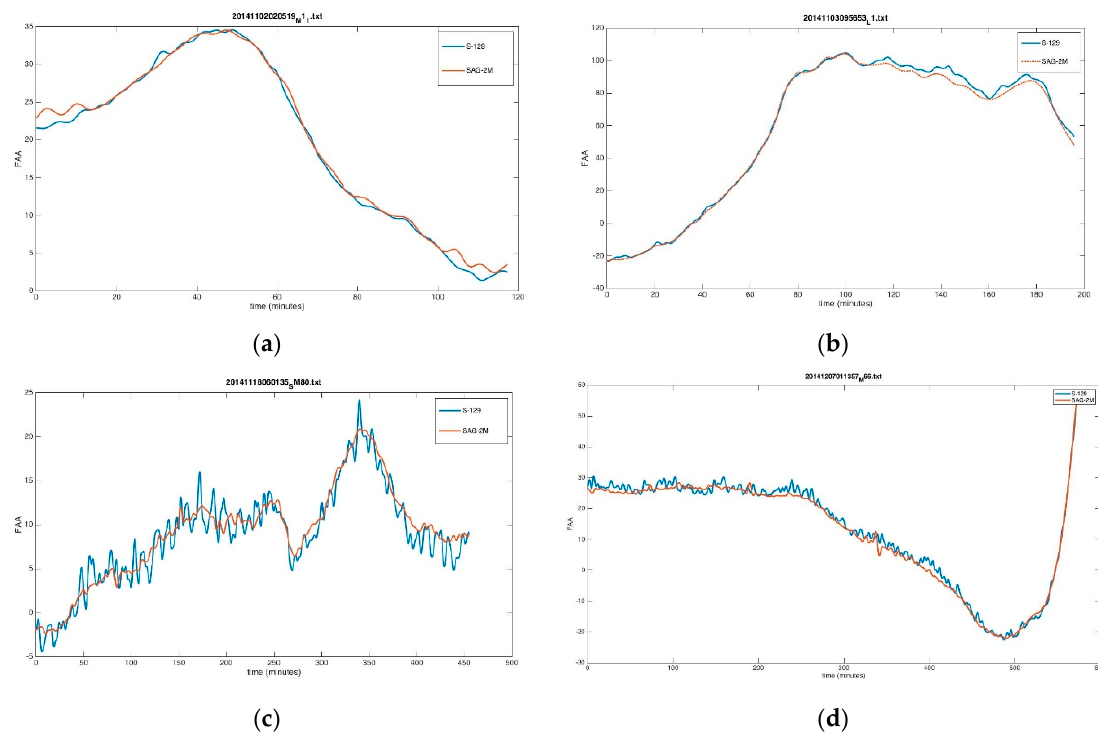
Figure 6. Profile comparison (blue profiles are the data acquired by S-129, and red profiles are the data acquired by SAG-2M).